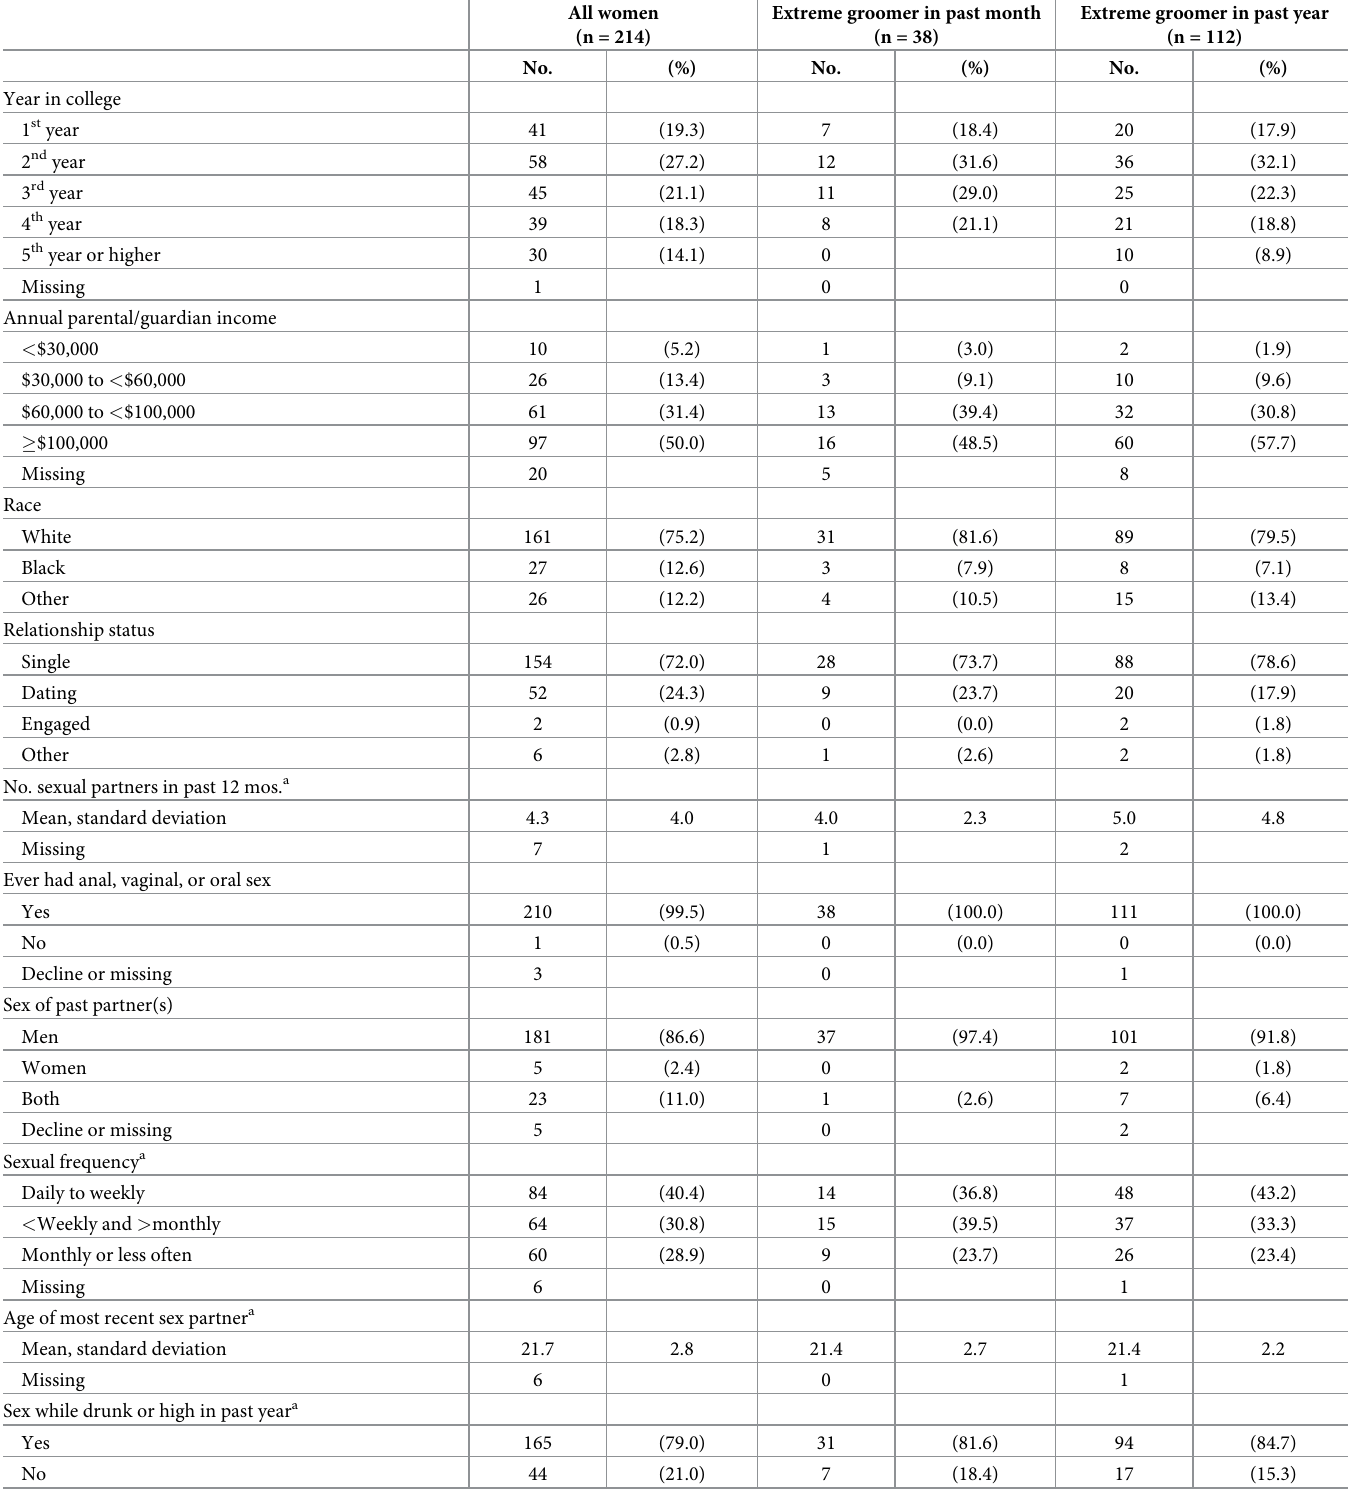
Table 1. Demographic characteristics and sexual behaviors among female university students attending for sexually transmitted infection